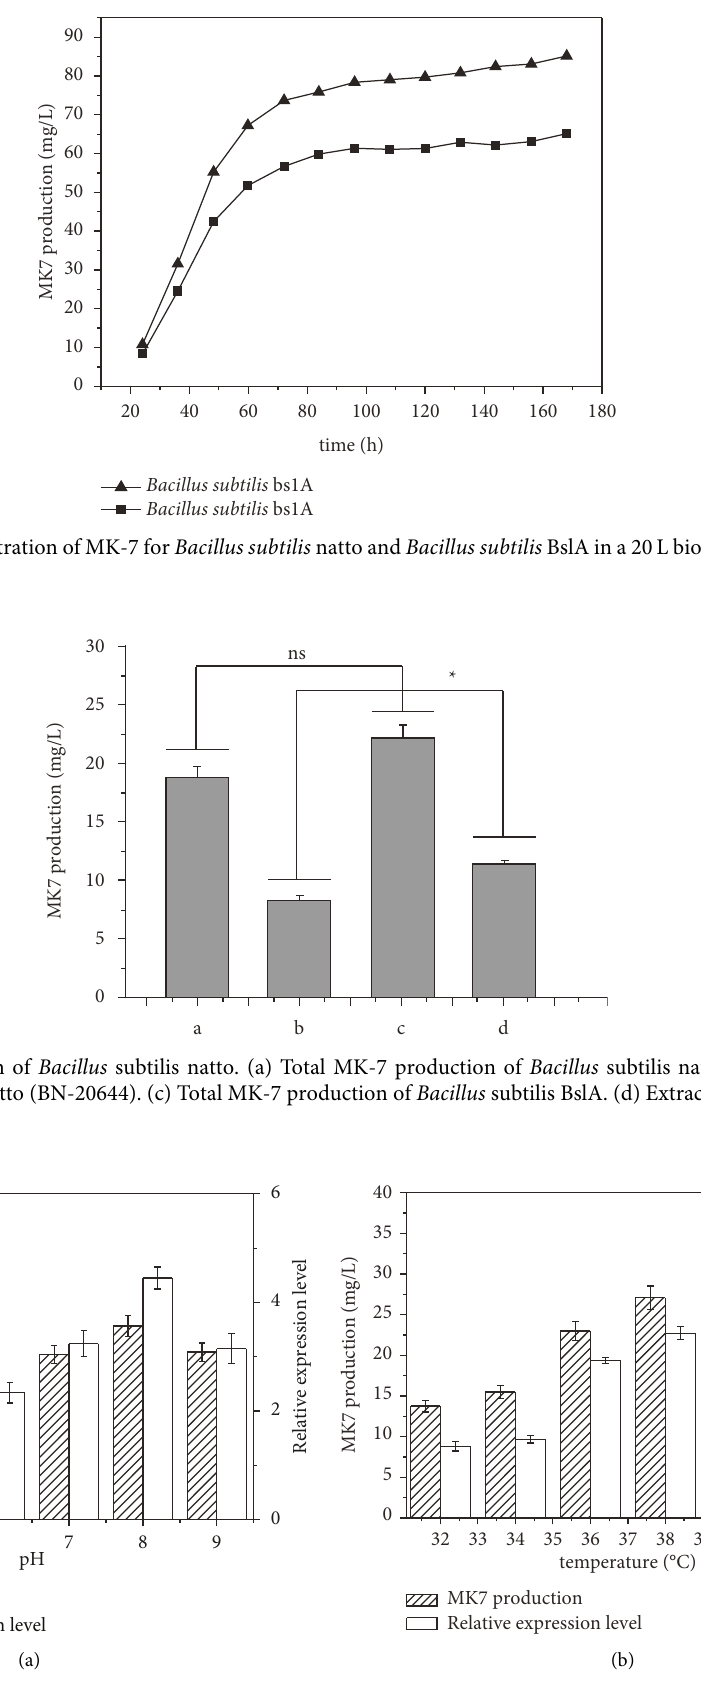
Figure 6: Effects of culture conditions on the expression level of bslA. (a) The expression of BslA at different initial pH values (at 37 ° C for 48h). (b) The expression of bslA at different temperatures (at initial pH 8.0 for